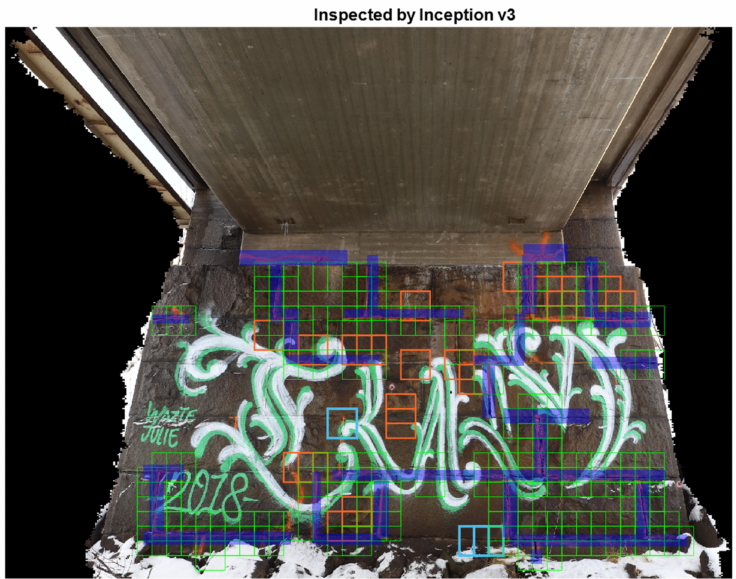
Figure 12. Damage detected by studied CNNs (green bounding boxes) compared to on-site inspection (highlighted blue strips), together with damaged areas detected by CNN which were not detected by human inspector (blue bounding boxes) and false detected damaged areas (orange bounding